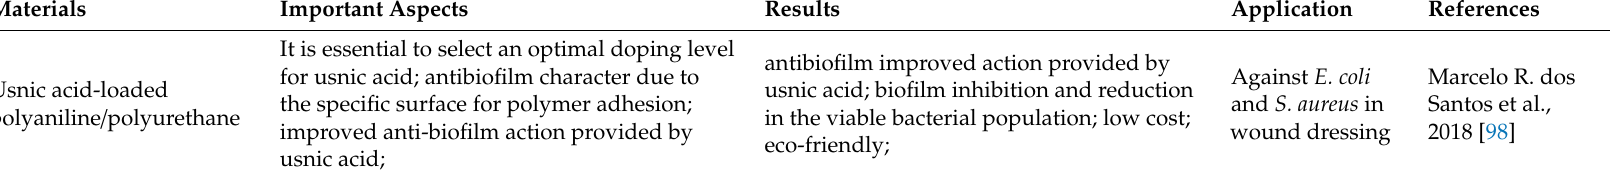
Table 1. Studies concerning polyurethane-based semipermeable dressing